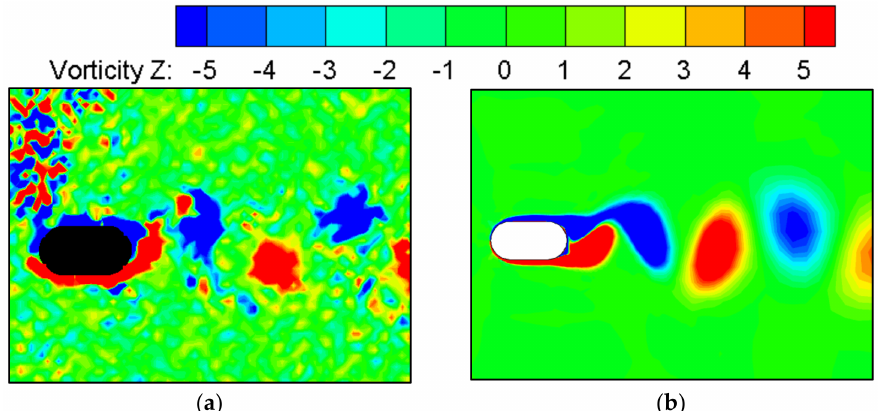
Figure 18. Schematic of the vorticity field around a circular-ended pier surface: ( a ) Physical model test results; ( b ) Numerical simulation